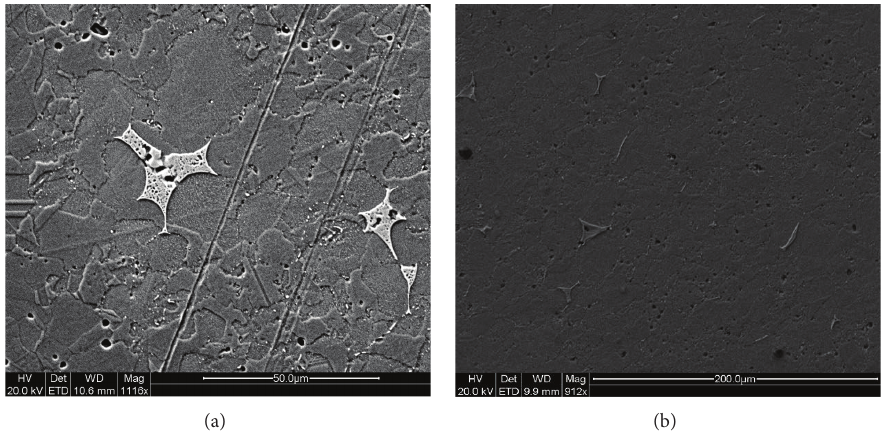
Figure 4: SEM images of: (a) Cu + 10 wt.%, (b) 20 wt.% Ag72Cu powder sintered at 825 ∘ C, 45 MPa, 100 ∘ C min −1 , 20 min hold time.